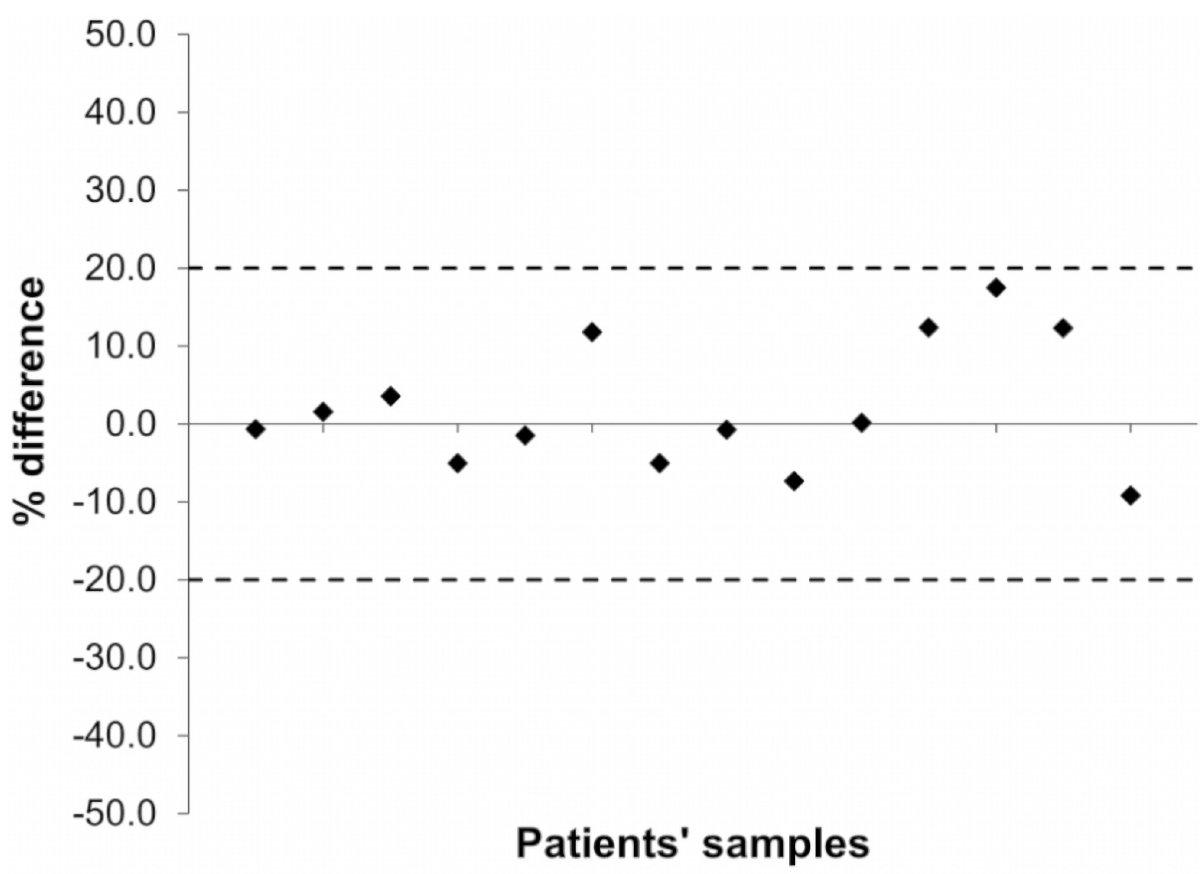
Fig 3. Incurred samples reanalysis: Percentage difference between the first and the second analysis for 14 plasma samples from 6 patients. The dotted lines represent the ± 20% deviation limits imposed by EMA and FDA guidelines.